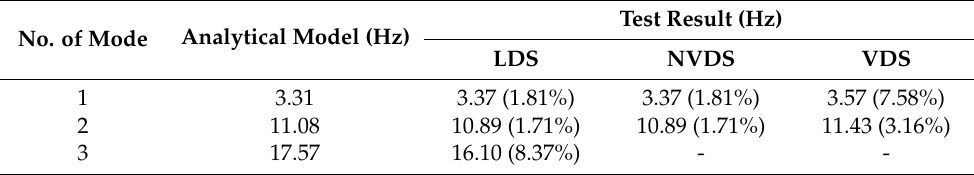
Table 2. Displacement data reliability results in the white noise test.